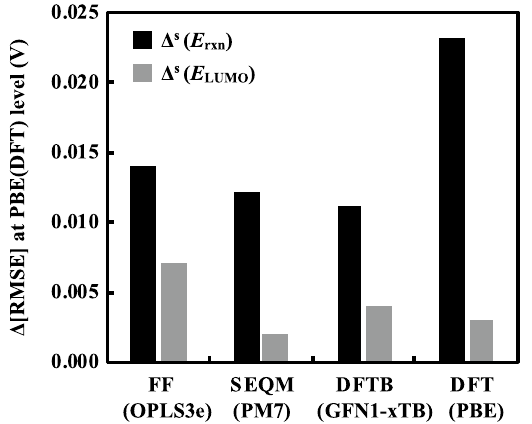
Figure 5. Bar plot showing the decrease in error, Δ[RMSE], due to the inclusion of implicit solvation. A larger value of Δ s implies higher improvement in the accuracy of the predicted results. The black solid bars represent Δ s ( E rxn ), whereas the grey solid bars represent Δ s ( E LUMO